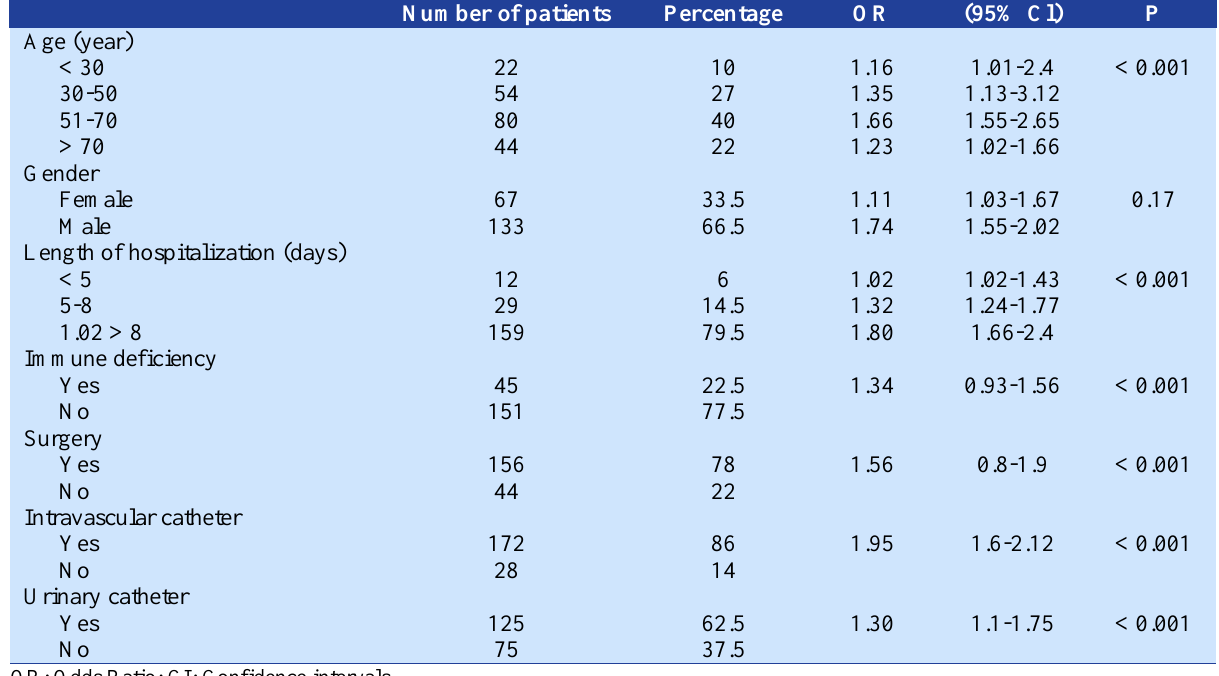
Table 1. The characteristics of the 200 inpatients included in the prevalence survey Number of